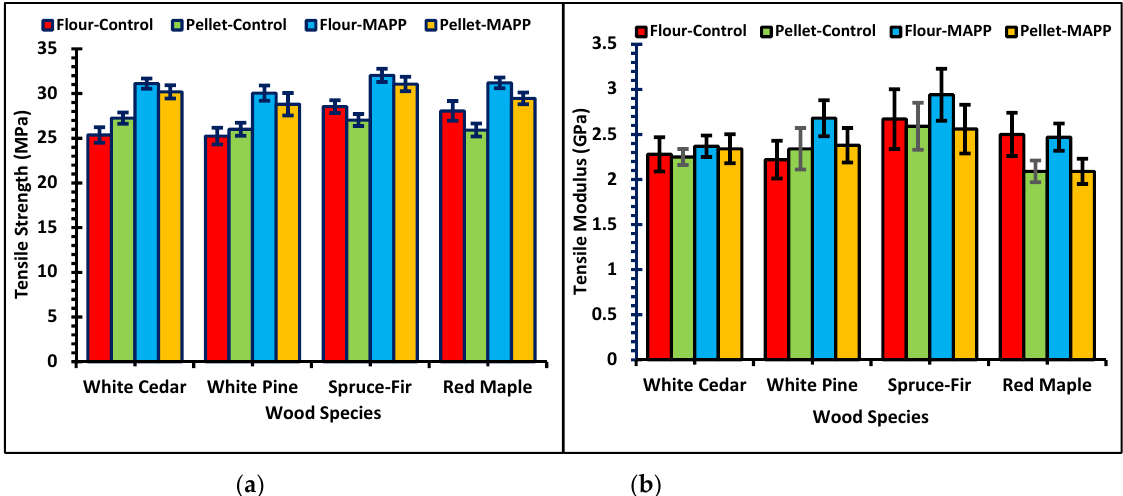
Figure 5. Graphs of ( a ) Tensile strength of WPCs and ( b ) Tensile modulus of WPCs. Table 3. Tensile strength and % elongation at yield and break for different formulations of WPCs. Wood Species